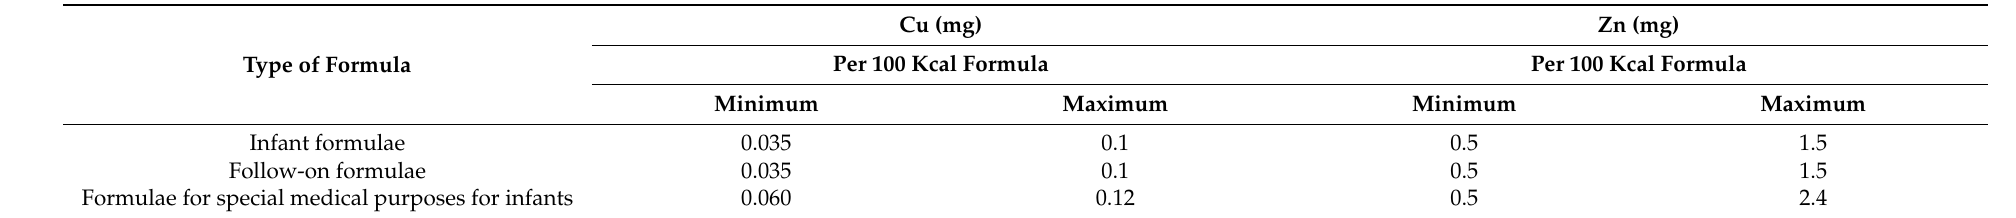
Table 3. Minimum and maximum Cu and Zn content requirement in formulae for infants per 100 kcal formulae